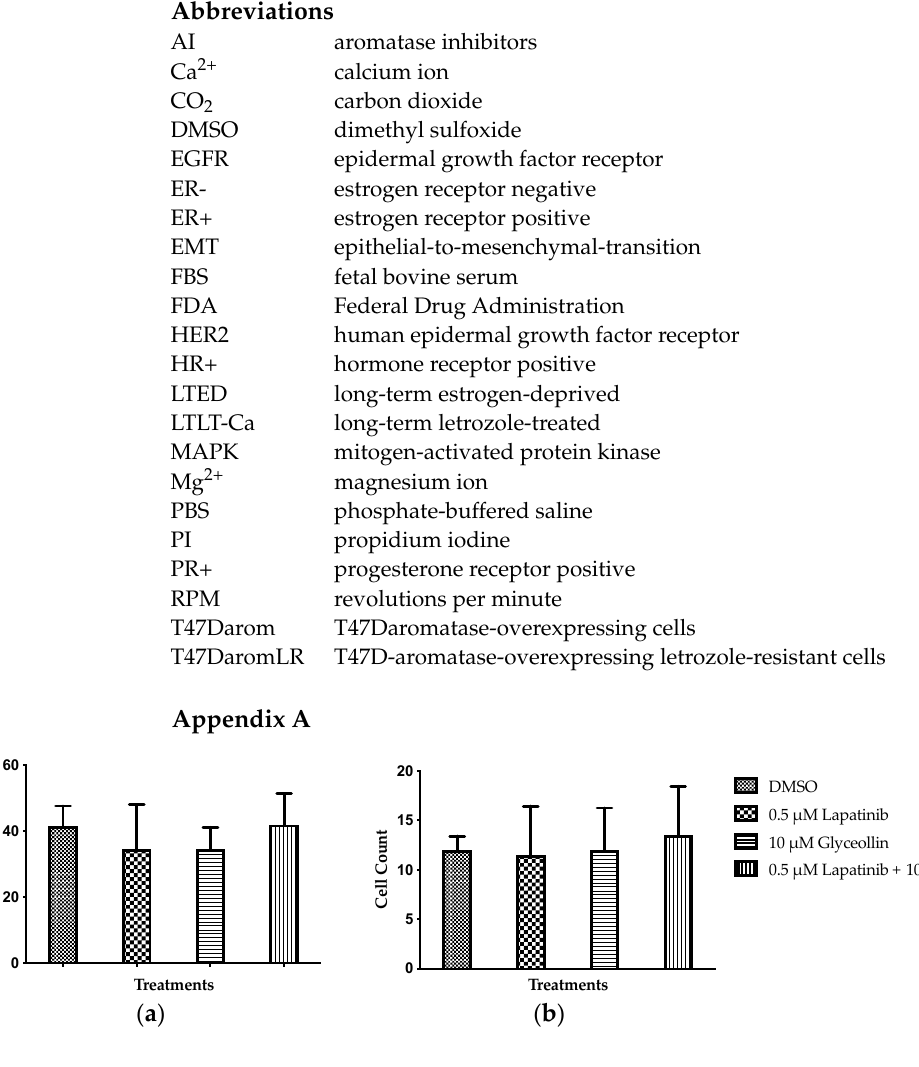
Figure A1. Glyceollin and/or lapatinib does not alter T47Darom or T47DaromLR cell migration. Migration assays were performed using ( a ) the T47Darom cells and ( b ) the T47DaromLR breast cancer cells. Both cell lines were cultured in standard growth media and treated for 24 h with DMSO vehicle control, 0.5 µ M lapatinib, 10 µ M glyceollin, or 0.5 µ M lapatinib 10 µ M glyceollin as described in the section. Cells were stained using 0.5% crystal violet in 1% methanol, and graphs depict the number of cells that migrated after 24 h. Student’s t ‐ tests were conducted, and treatments were compared to the control. Results are expressed as the mean unit ± SD of three independent experiments in triplicate.